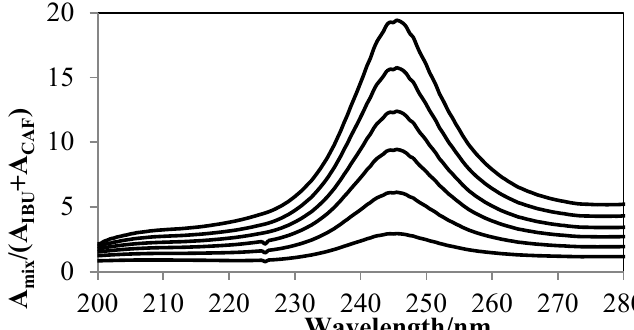
Figure 5: Double divisor of the ratio spectra for a ternary mixture of paracetamol, caffeine and ibuprofen in 10 µmol L -1 for each component after simultaneous standard addition of components in the concentration range of 10-60 µmol L -1 . Conditions: double divisors (IBU,